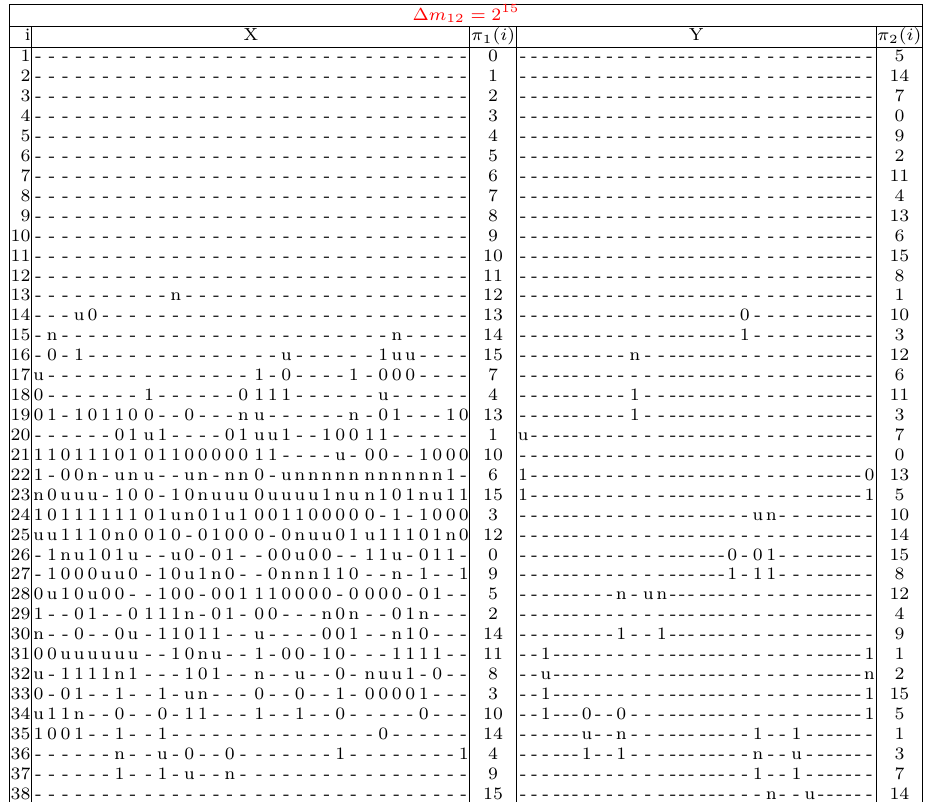
Table 14: 38-step differential